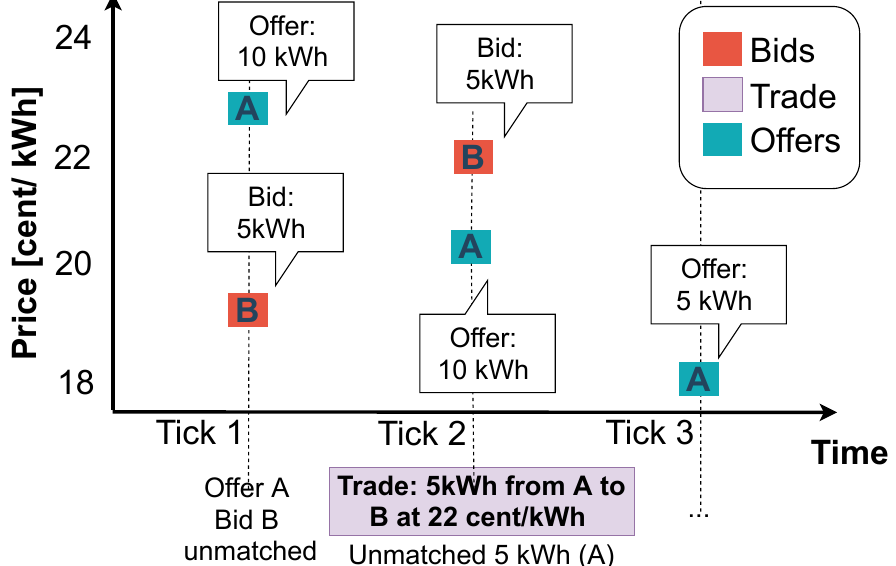
Figure 3. Example of market-clearing within a market slot in the continuous pay-as-bid